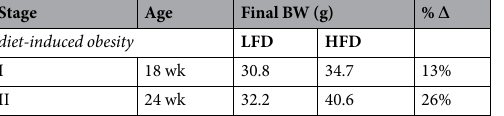
Table 1. Anthropometrics of mice in this study. Percent difference in body weight (BW) between lean and obese mice (% ∆